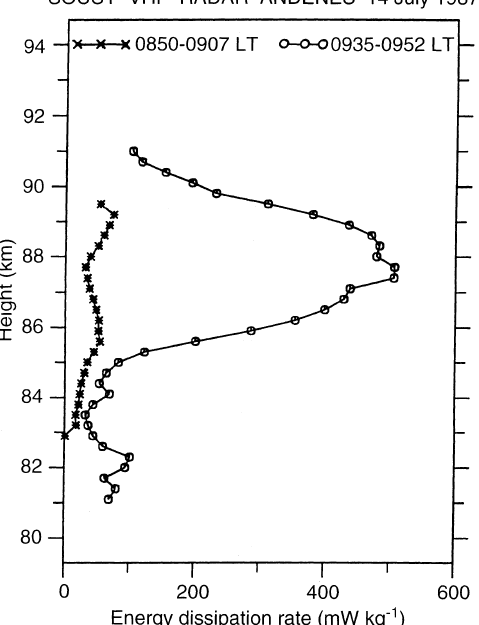
Fig. 11. Height profiles of energy dissipation rates at time periods of broad ( circles ) and narrow ( asterisks )